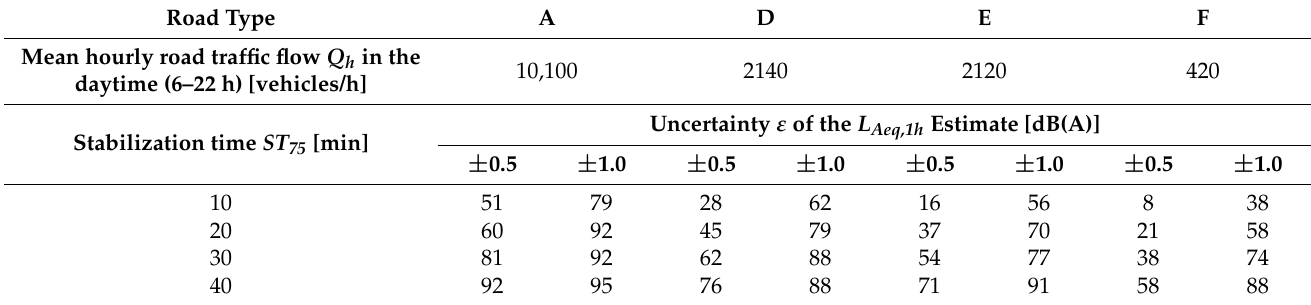
Table 5. Cumulative probability [%] of the L Aeq,1h estimate computed by Equation (5) for each road type and uncertainty ε for some ST 75 values and daytime mean hourly road traffic flow Q h